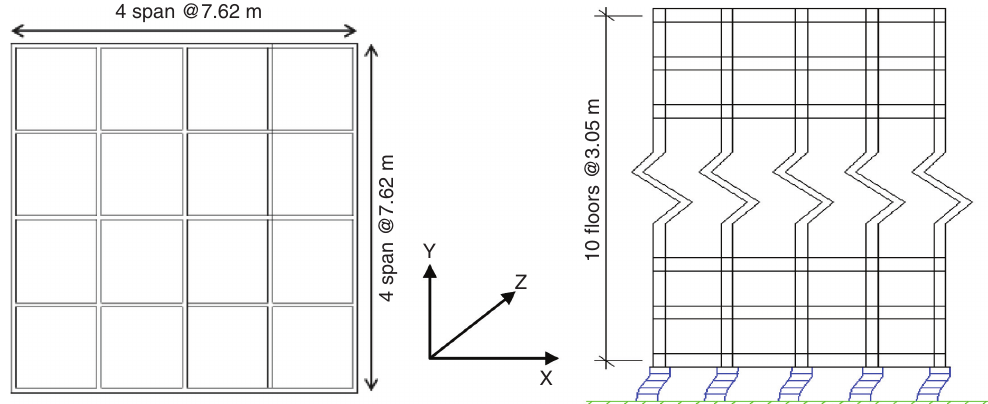
Fig. 1. Structural model of the multi storied building ( fi xed or